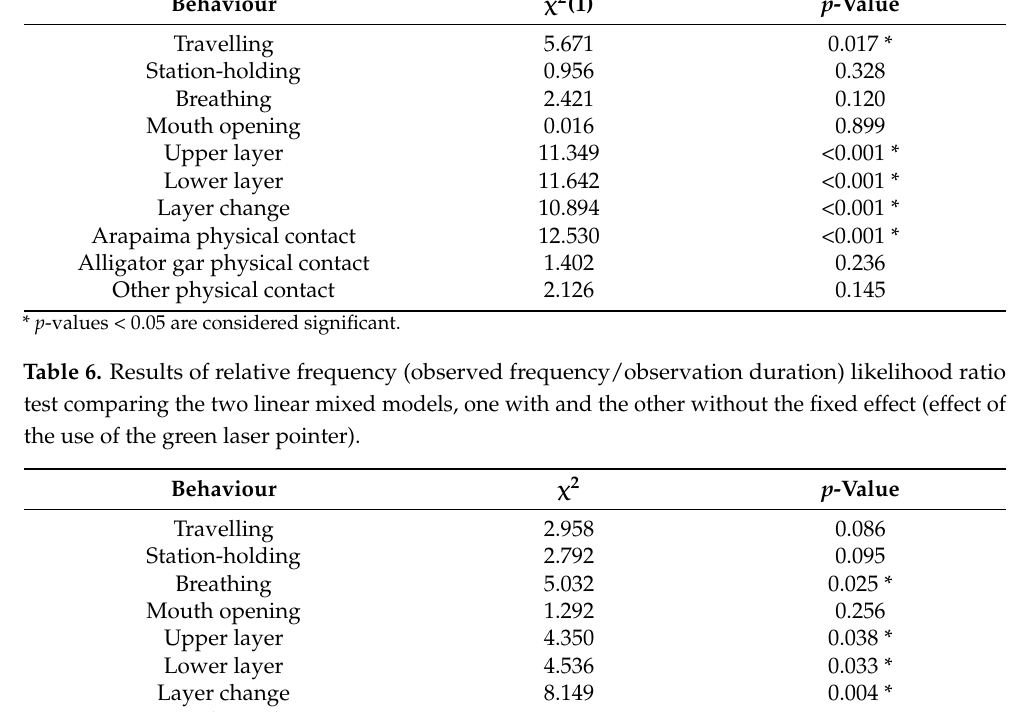
Figure 4. The relative frequency (observed frequency/fish presence in the exhibit tank) of the ten monitored behaviours during test (blue) and baseline (white) conditions. Boxplots represent the median and interquartile range (IQR) with whiskers indicating the top and bottom 5% of occurrences and outliers are represented by the circles. Significant change between baseline and test conditions is marked with asterisks (* p > 0.05, ** p > 0.01). The documented changes were the most apparent in Beth’s behaviour (Figure 5). She spent more time travelling and in the upper layer during test sessions.